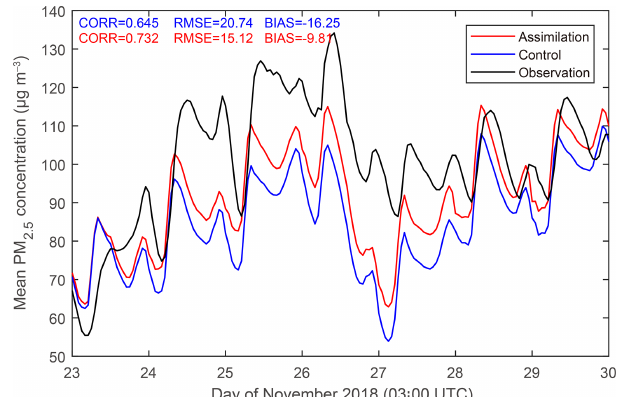
Figure 13. Time series of surface PM 2 . 5 simulated by the control experiment (blue) and the assimilation experiment (red) as well as corresponding observations (black), as averages over 683 stations in D02. The simulations are representative of hourly 0–23h forecasts in D02 from 03:00UTC every day during the whole forecasting pe- riod using